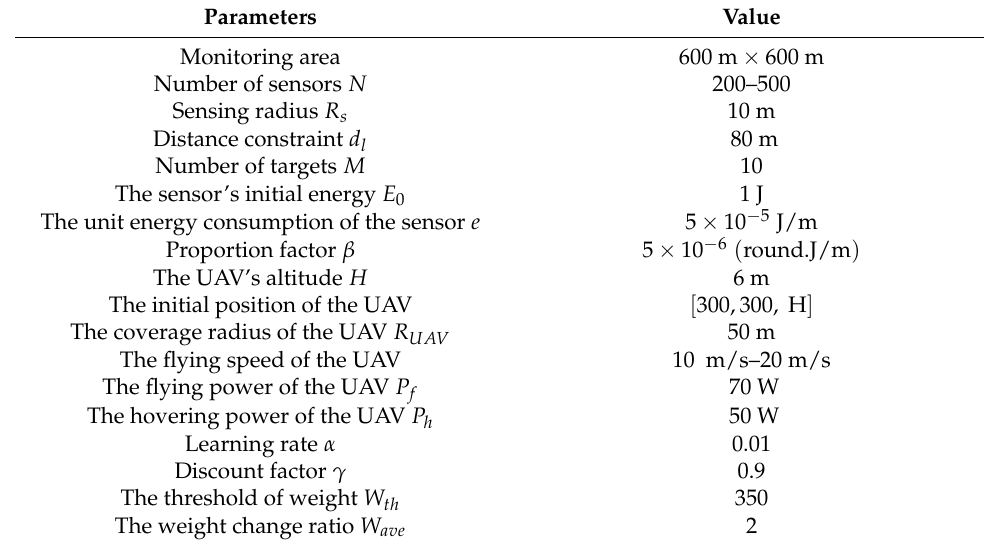
Table 1. Simulation